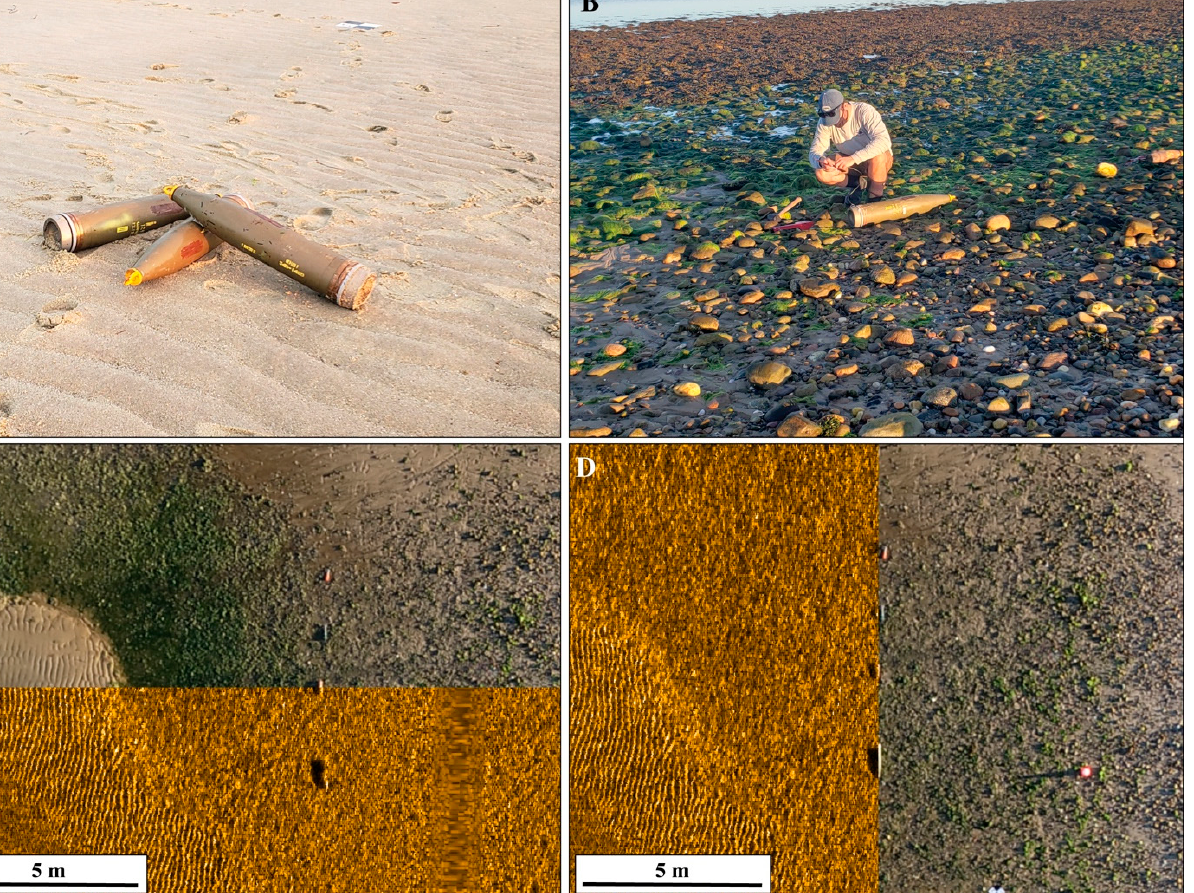
Figure 2. Intertidal survey areas. ( A ) Site 1, a sandy intertidal flat with a group of three 155 mm, wax-filled mortar shells. This group underwent no observable movement between one LT-HT-LT cycle based on RTK-GPS measurements. ( B ) Site 2, a mixed sand and gravel beach with many cobble-sized material. A single 155 mm, wax-filled mortar shell. ( C ) Site 2, horizontal sidescan data over the UAS imagery. Note the alignment of the second from the bottom target in both datasets. The bedforms in the lower left exhibit 12–15 cm spacing. ( D ) Site 2, vertical sidescan overlay over UAS imagery. Note the shadows in the lower two targets seen in the sidescan data.